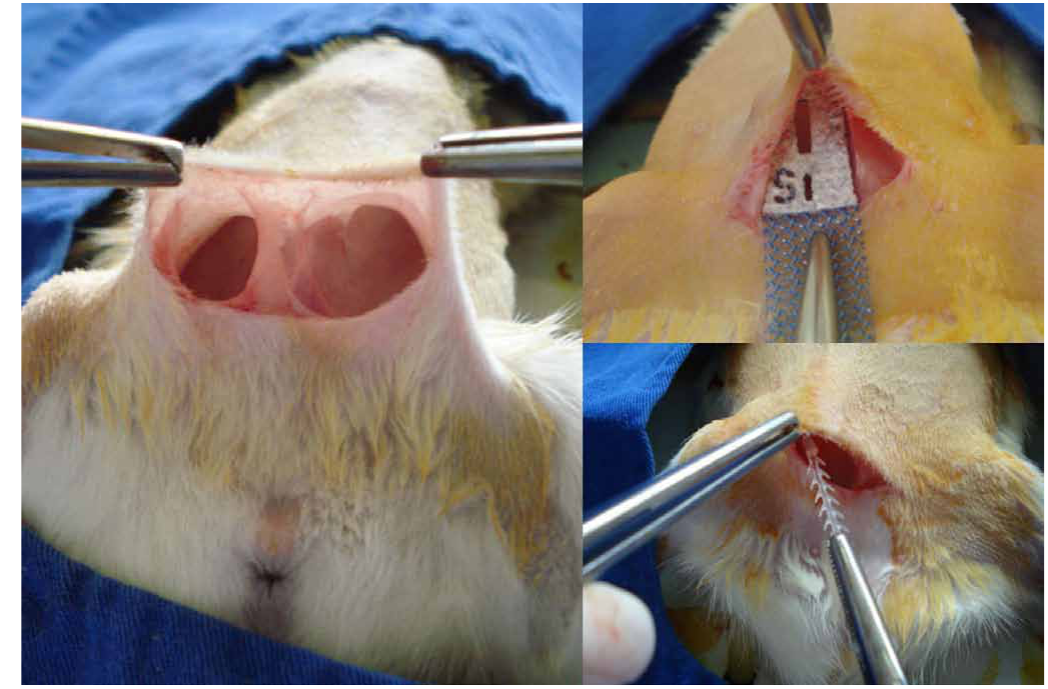
Figure 2 - Surgical